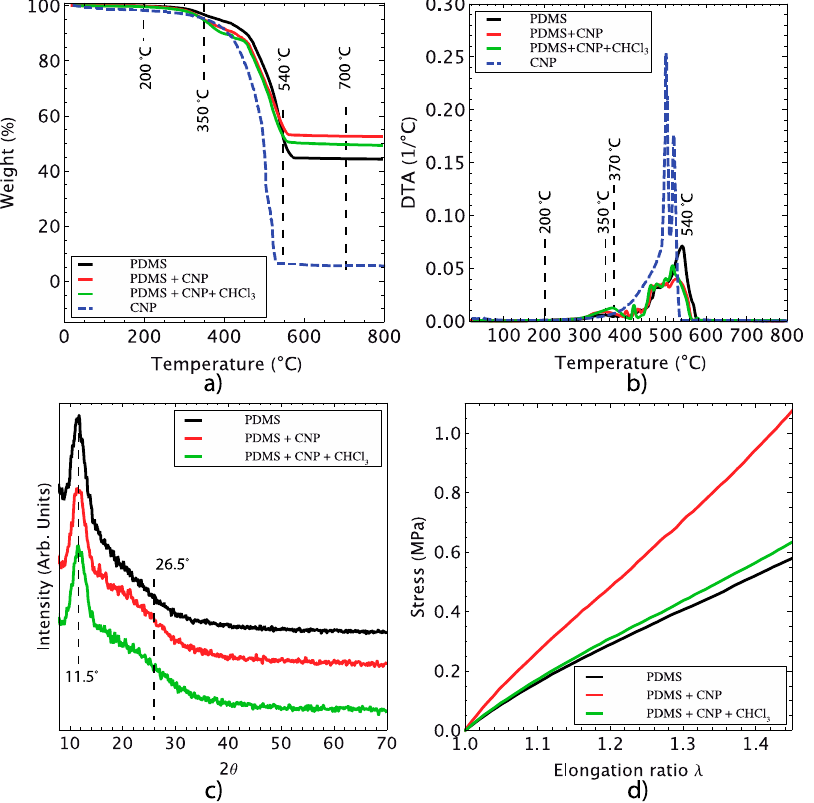
Figure 5. Thermal and mechanical characterization of the composite membranes: ( a ) thermogravimetric analysis of PDMS and its composites; ( b ) derivatives of thermogravimetric analysis evidencing the critical temperatures of degradation for PDMS and its composites; ( c ) X-ray diffraction spectra showing amorphous and crystalline features of PDMS and composites; ( d ) mechanical response of PDMS and composites under uniaxial tensile load.